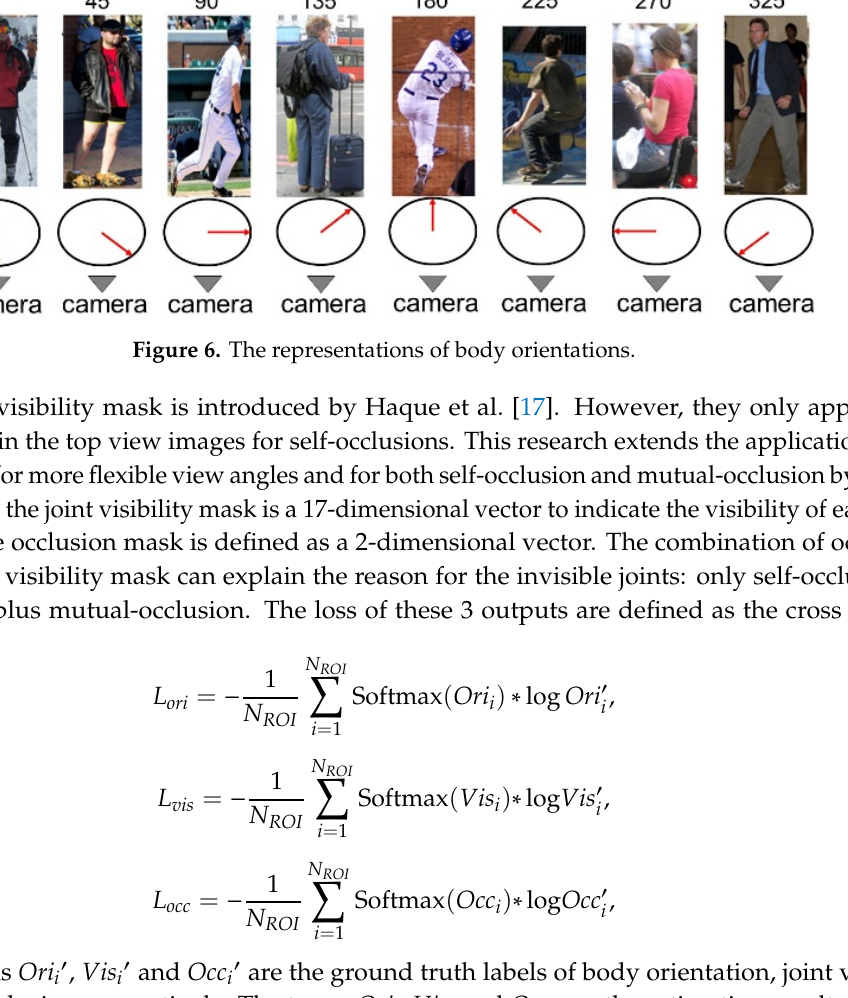
Figure 5. Architecture of the orientation ‐ occlusion branch.